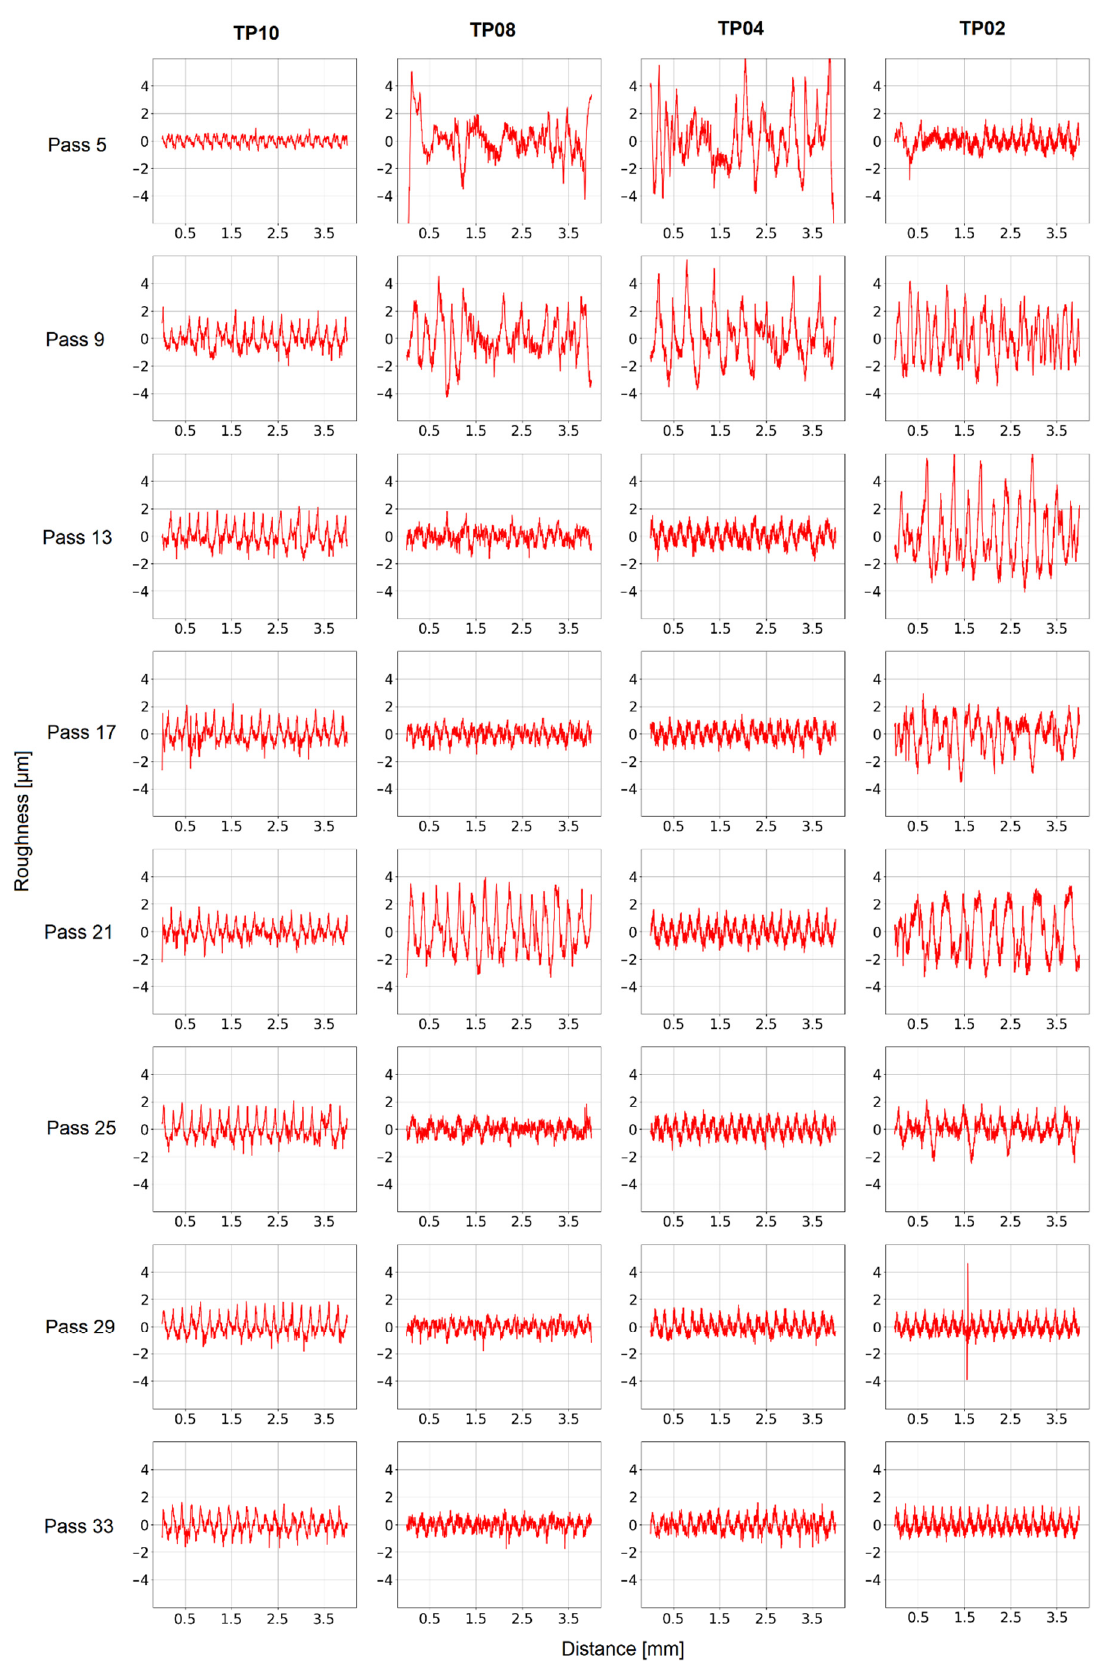
Figure 11. Roughness profile.